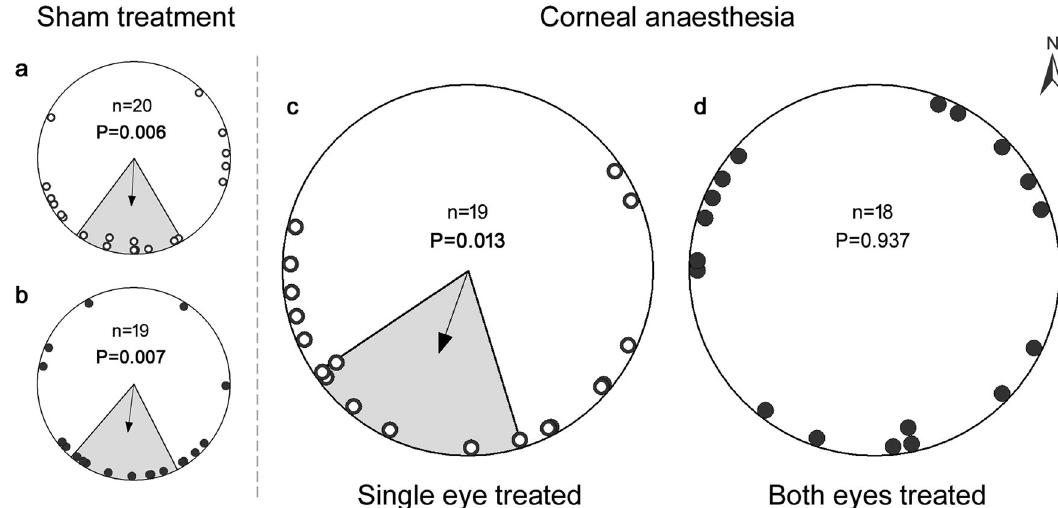
Fig. 1 Migratory Nathusius ’ bats vanish in random directions if corneal sensation is inhibited in both eyes. a and b show control bats that received eye drops of saline solution as a sham treatment before release. c Experimental bats that randomly received a topical anaesthetic to the left or right eye ’ s cornea and sham treatment for the other eye, accordingly. d Bats with bilateral topical corneal anaesthesia. Empty and fi lled dots indicate animals that were tracked on the same nights. Arrows depict the group mean vectors in non-randomly oriented groups of bats with the magnetic North (0°) always on top of all plots. Grey sectors encompassing the group mean vectors indicate the 95% con fi dence intervals for the mean. P -values from Rayleigh tests are shown. Total sample size: n =